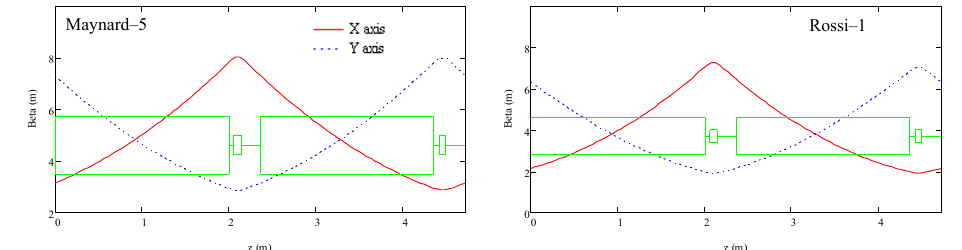
Figure 1. Magnetic unit cell of the system made up of undulator, focusing and defocusing quadrupoles for the λ u = 2 cm configuration, associated to the specified electron beams, superimposed to the longitudinal profiles of Twiss β x (solid red line) and β y (dotted blue line) functions. The strategy to match the beams is based on minimizing the difference between average Twiss β (cid:12) (cid:12) values, (cid:12) (cid:104) β x (cid:105) − (cid:104) β y (cid:105) (cid:12) , also featuring reasonable magnetic gradients, for both the short and the long λ u